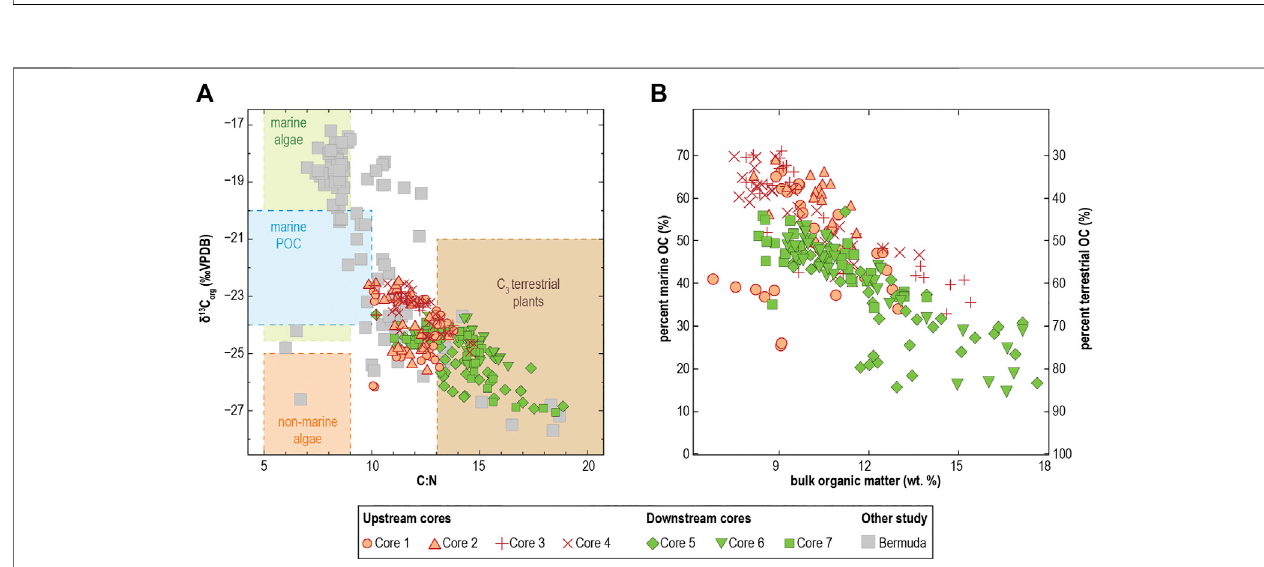
FIGURE 5 | (A) Cross-plot between stable carbon isotopic values ( δ 13 C org ) and C:N ratio of bulk organic matter in Aerolito Cave (this work) and Bermuda caves (Cresswell and van Hengstum, 2021). (B) Cross-plot between bulk organic matter content (Classic LOI, weight %) and the percent marine/terrestrial organic carbon as calculated from the two-endmember mixing model based on δ 13 C org